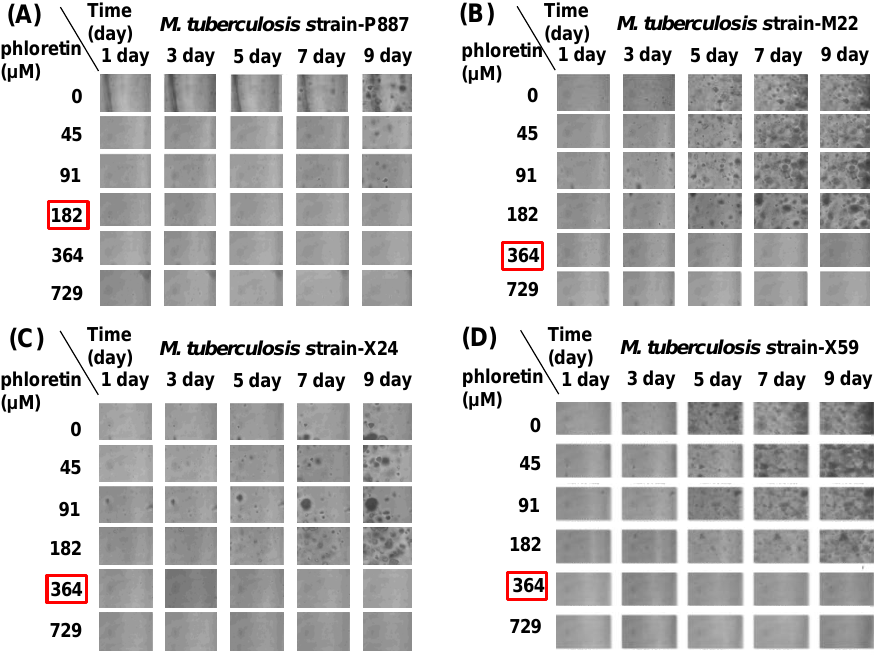
Figure 2. Effects of phloretin on the growth of ( A ) M. tuberculosis P887 (H37Rv); ( B ) M. tuberculosis M22 (multidrug resistant); ( C ) M. tuberculosis X24 (extensively drug resistant); and ( D ) M. tuberculosis X59 (extensively drug resistant) strains. Red squares denote the MIC 90 for each strain.